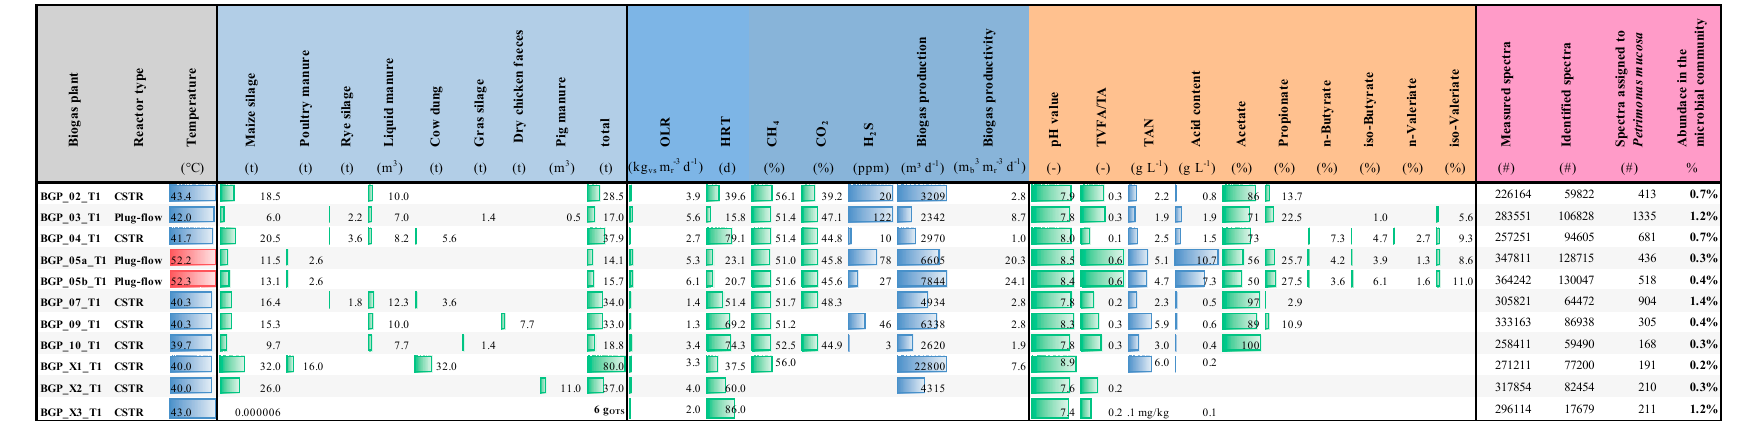
Figure 6. Abundance of P. mucosa ING2-E5A T in biogas-producing communities as deduced from metaproteome analysis. Metaproteome datasets originating from eight di ff erent biogas plants represented by 11 reactors published previously [53] were investigated. The measurements were searched with X!tandem and OMSSA against the protein database derived from original data extended with the sequences of Petrimonas mucosa proteins. Subsequently, an FDR of 1% was applied and redundant peptide identifications were grouped when they shared the same peptide set. The main process parameters for the investigated biogas plants were adopted from the original publication [53]. Blue and red bars mark the mesophilic or thermophilic process temperature, respectively. Green bars visualize the values of the di ff erent parameters. CSTR: continuous stirred tank reactor; OLR: organic loading rate; HRT: hydraulic retention time; VS: volatile solids; TS: total solids; TVFA / TA: total volatile fatty acids to total alkalinity; TAN: total ammonia nitrogen; m b3 : cubic meter biogas; m r3 : cubic meter reactor volume; kg vs : kilogram VS.